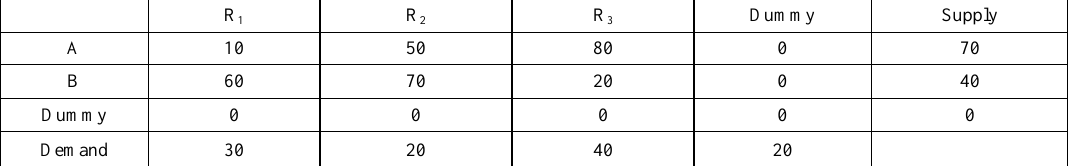
Table 9. Transportation cost for first point transportation